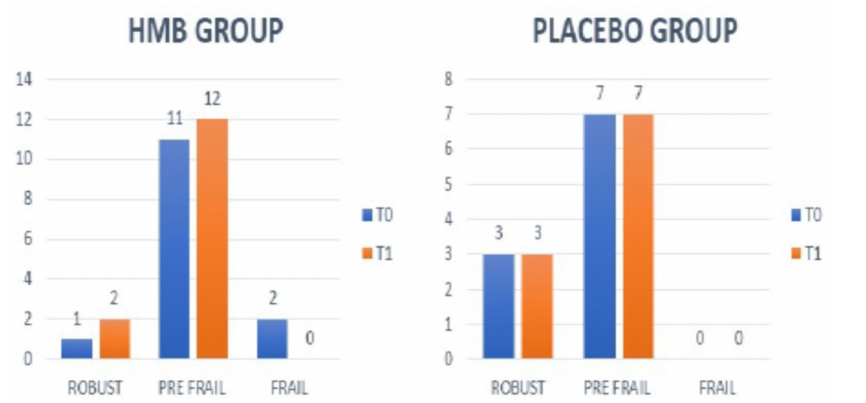
Figure 1. Modification of frailty during follow-up in patients of placebo and HMB